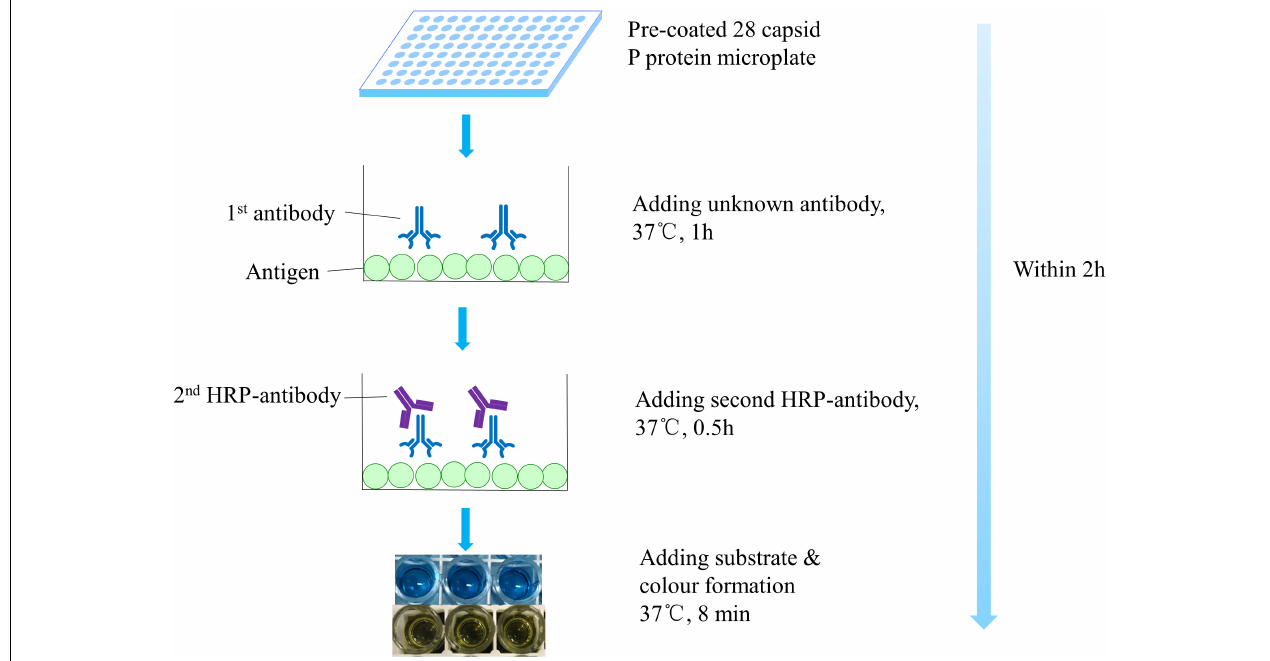
FIGURE 1 | Step-by-step schematic representation of ELISA. Before addition of the antibody to be tested, the dilution corresponding to the OD value of 0.8–1.2 was determined. Broad-spectrum norovirus antibodies were determined within 2 h.